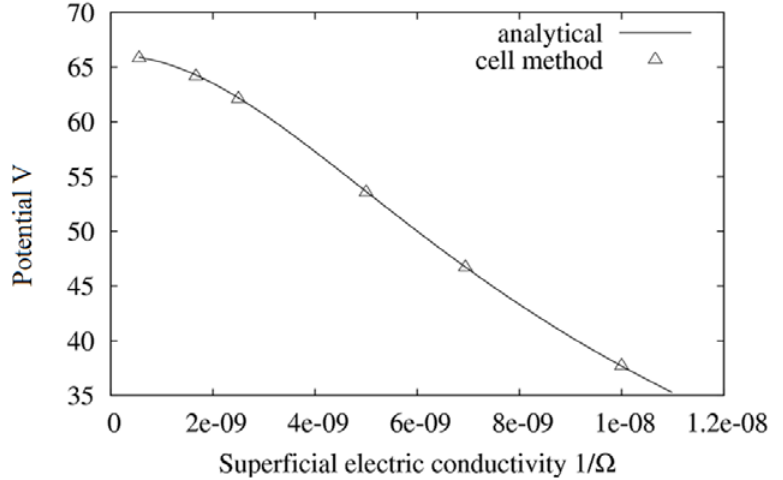
Figure 5. Graphical representation of maximal potential at the interface versus superficial electric